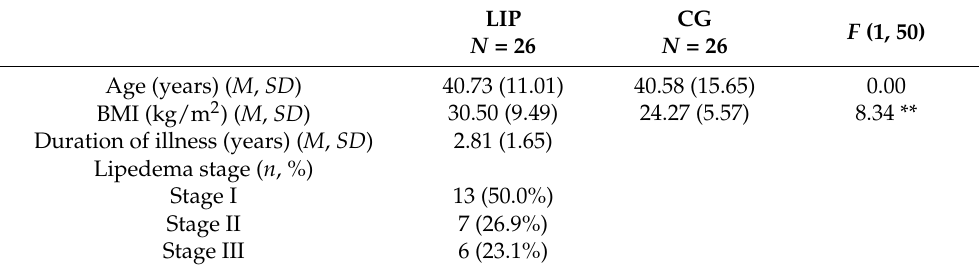
Table 1. Participant Characteristics.